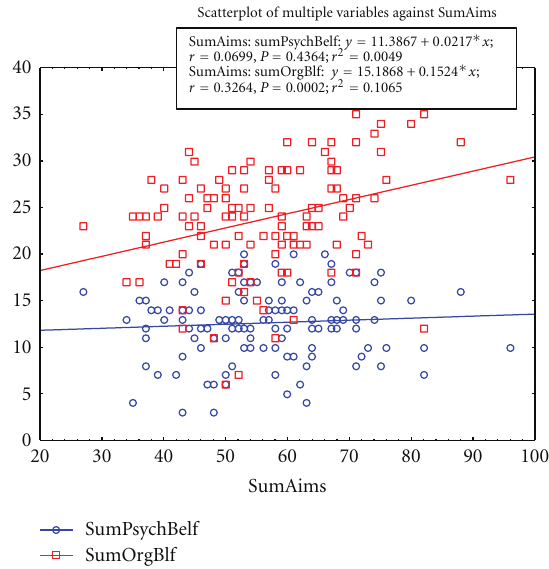
Figure 2: Scatterplot with linear regressions of the sum of AIMS2- SF disability with both the psychological subscale of the PBQ and the organic subscale of the